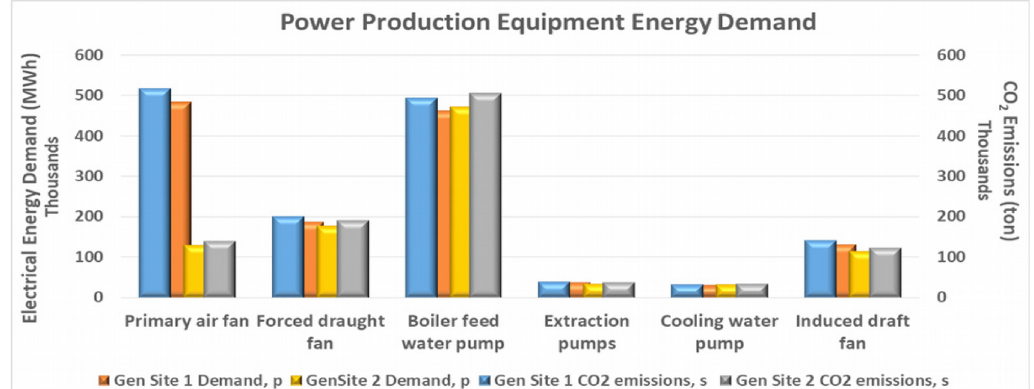
emissions of the corporate site 2